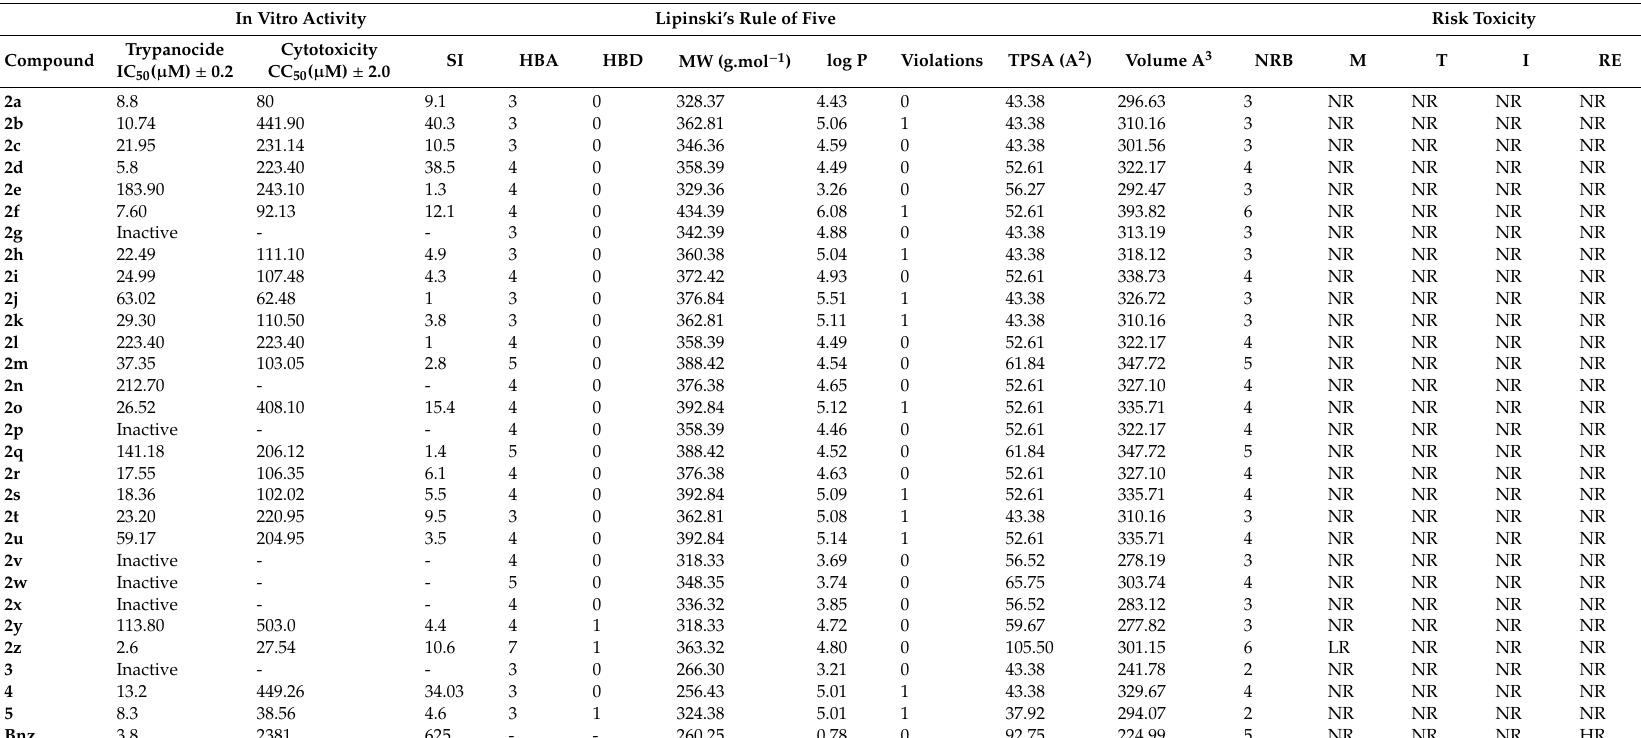
Table 1. In vitro trypanocidal activity, cytotoxicity, selectivity index, and physicochemical properties of bioactive flavanones. In Vitro